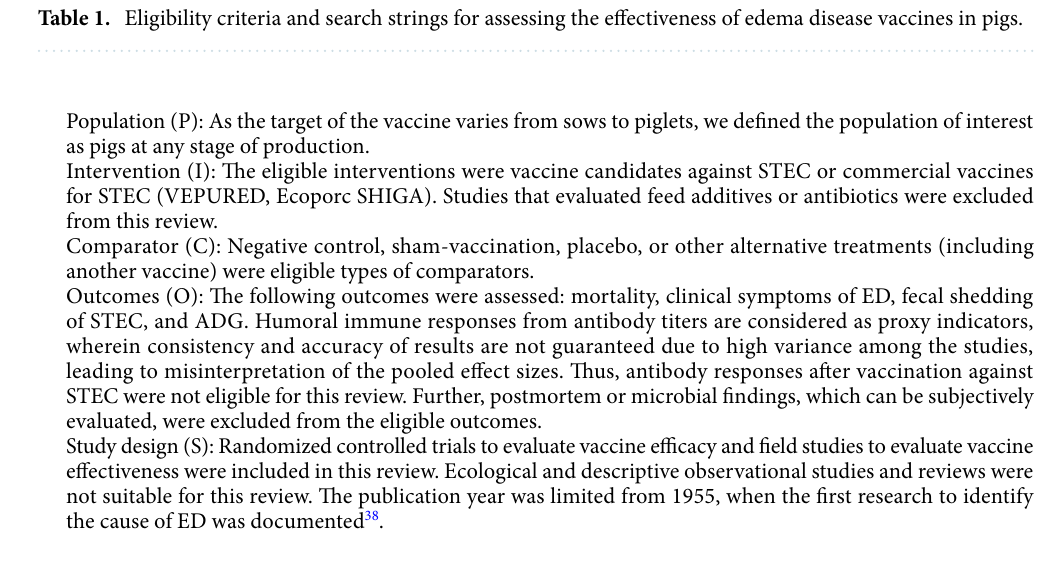
Table 1. Eligibility criteria and search strings for assessing the effectiveness of edema disease vaccines in